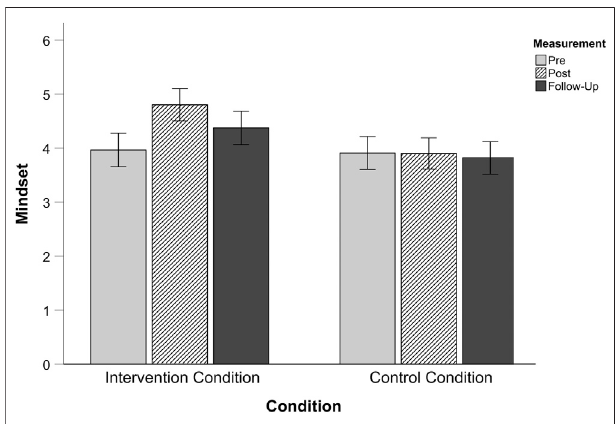
FIGURE 1 | Mean mindset values of the intervention and control condition at premeasurement, postmeasurement, and follow-up measurement. Error bars represent standard errors (95% CI). Amindset value ≥ 4 corresponds to a growth